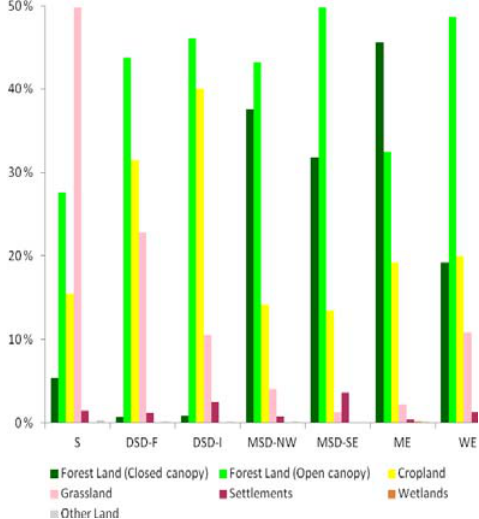
Figure 4. Land Use (LU) Classification Statistics over the Ecological Zones within the Study Area.